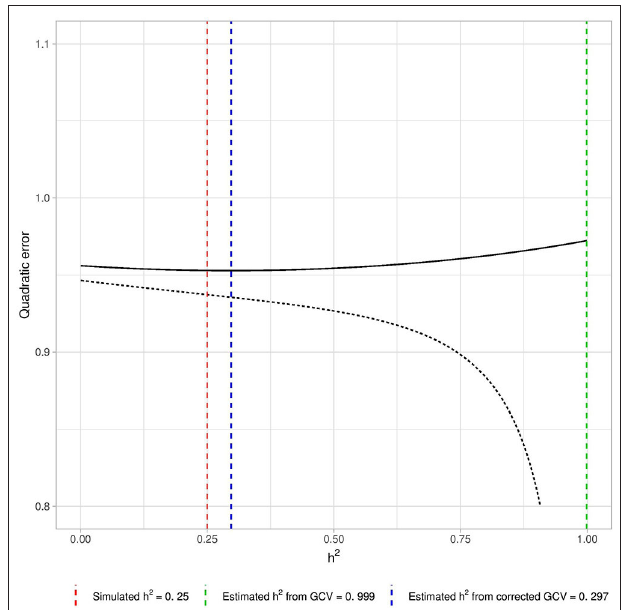
FIGURE 1 | Example of biased estimation by GCV if p > n . We computed the GCV error curve with n = 1,000 individuals, p = 10,000 causal variants and simulated heritability h 2 sim = 0.25. We used a grid of λ corresponding to the grid of heritability { 0.01,0.02,...,0.99 } using the link described in Equation (6) and computed the GCV error for those λ after empirical standardization of the data (dotted line). The λ that minimizes the GCV error corresponds to the heritability estimation. Here the GCV error tends to its minimum as h 2 tends to 1, and heritability is thus largely over-estimated. The plain line corresponds to the GCV error obtained after correction of this bias by the projection approach (see section 2.1.3), which provides a satisfactory estimation of h 2 . The three vertical lines correspond respectively to the simulated heritability (red line), the heritability estimated using uncorrected GCV (green line) and the heritability estimated using corrected GCV (blue